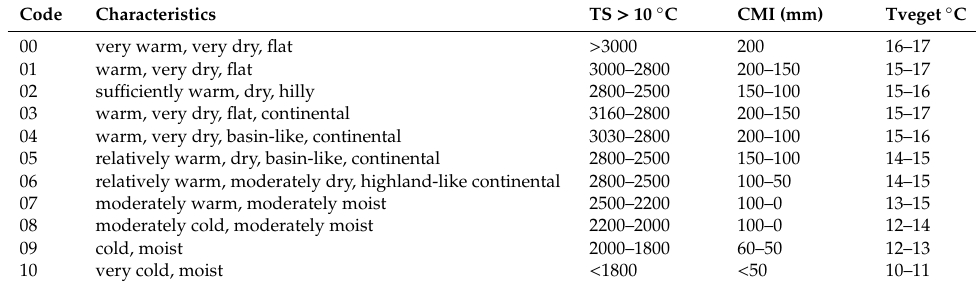
Table 1. Chosen parameters of soil and climatic regions in framework of Slovakia.